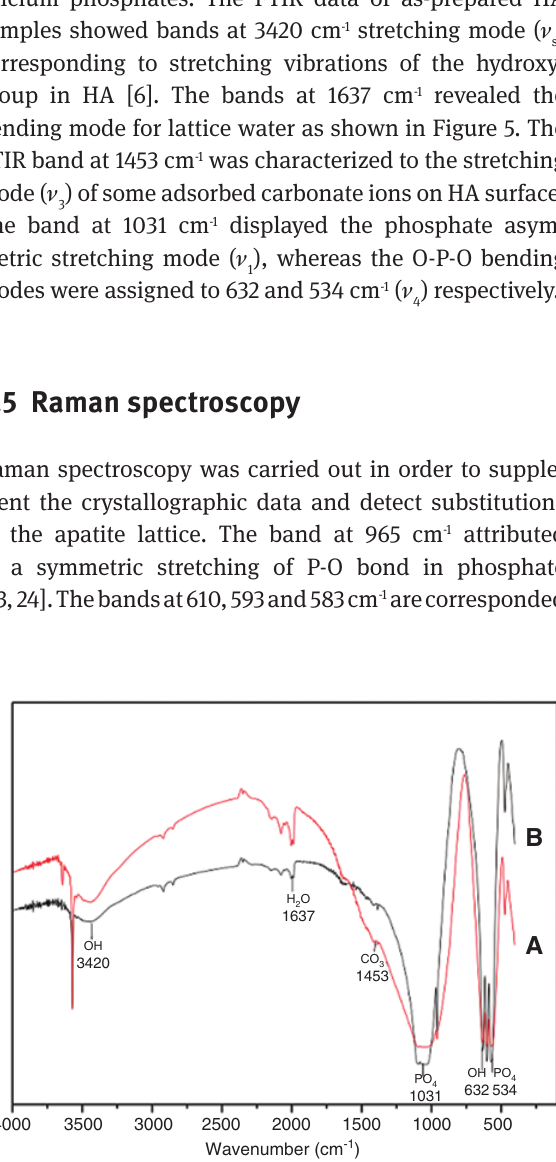
Figure 5: FTIR spectra of phase-pure hydroxyapatite nanorods, prepared by using method 1 (A) and method 2 (B) via co-precipita- tion technique.